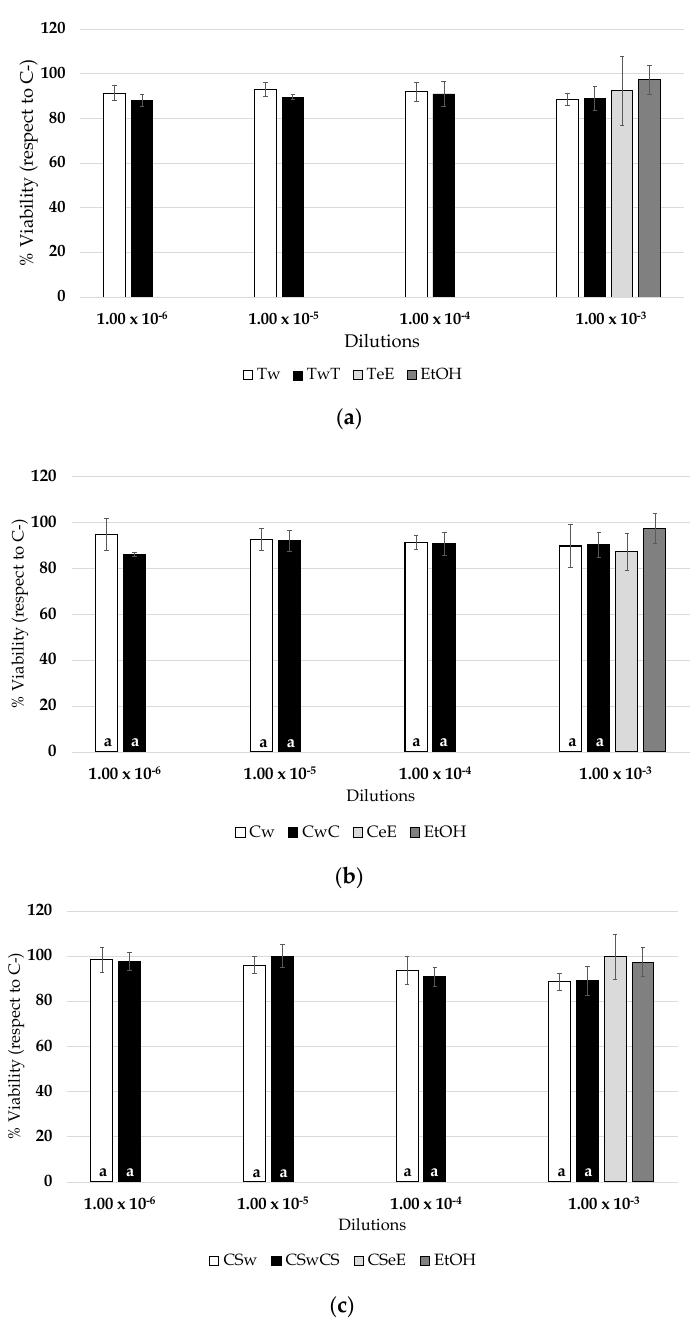
Figure 3. Effect on cellular viability of: ( a ) Tempranillo wines, with or without addition of their own vine − shoots; ( b ) Cencibel wines, with or without addition of their own vine − shoots; ( c ) Cabernet Sauvignon wines, with or without addition of their own vine − shoots. Different letters indicate significant differences among wines of the same variety according to the Fisher’s LSD test ( α < 0.05).